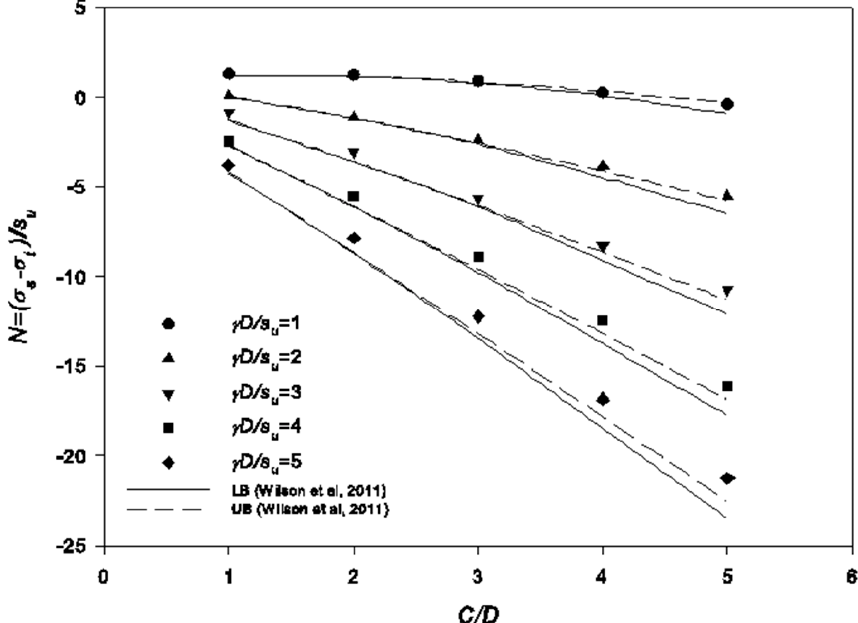
Figure 7. Comparison of critical stability numbers from this study with rigorous upper and lower bounds from Wilson et al. (2011).